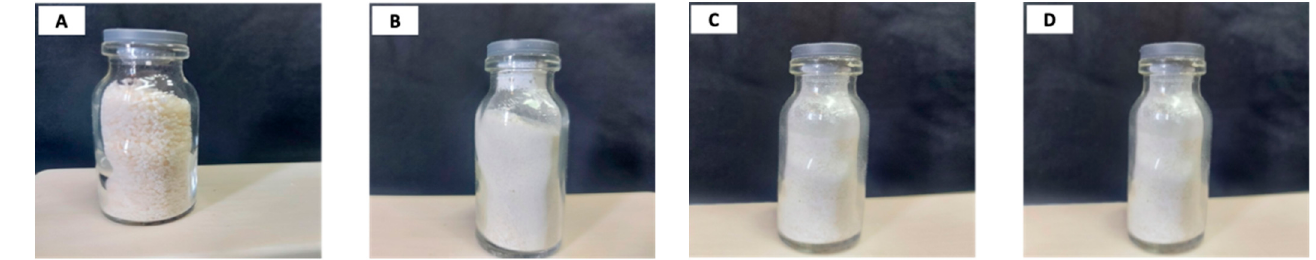
Figure 1. Photo images of ( A ) sodium alginate, ( B ) ZnONPs-1, ( C ) ZnONPs-2, and ( D ) ZnONPs-3 synthesized in their solid form.